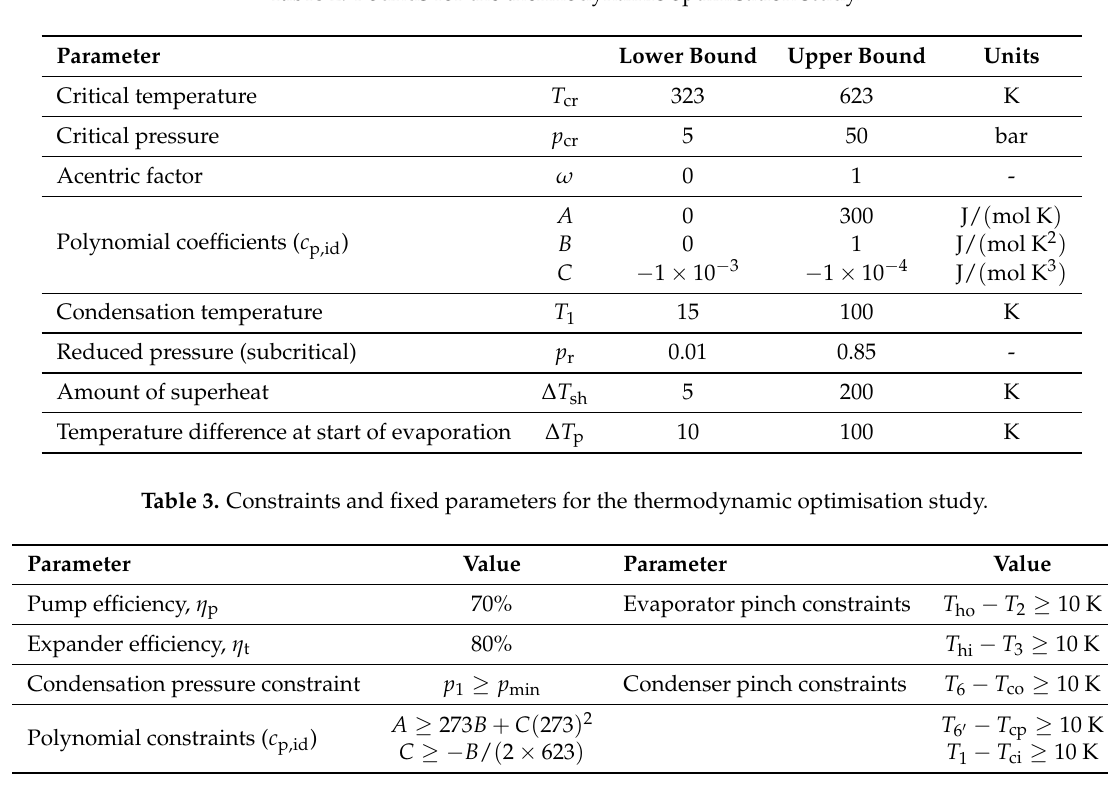
Table 2. Bounds for the thermodynamic optimisation study.